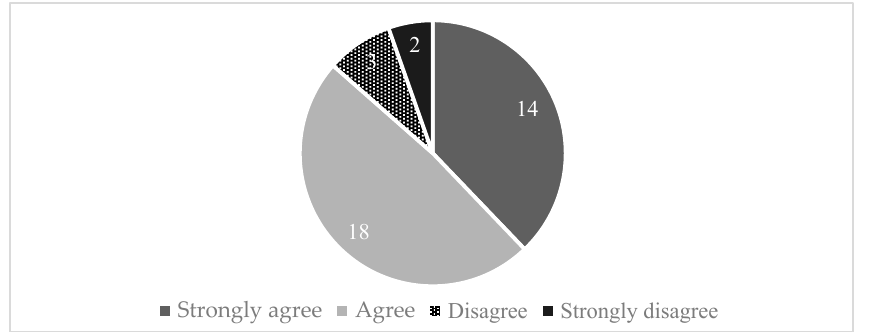
Figure 2. Respondents’ attitudes regarding the statement that in China, building material waste during the demolition phase is a serious issue.